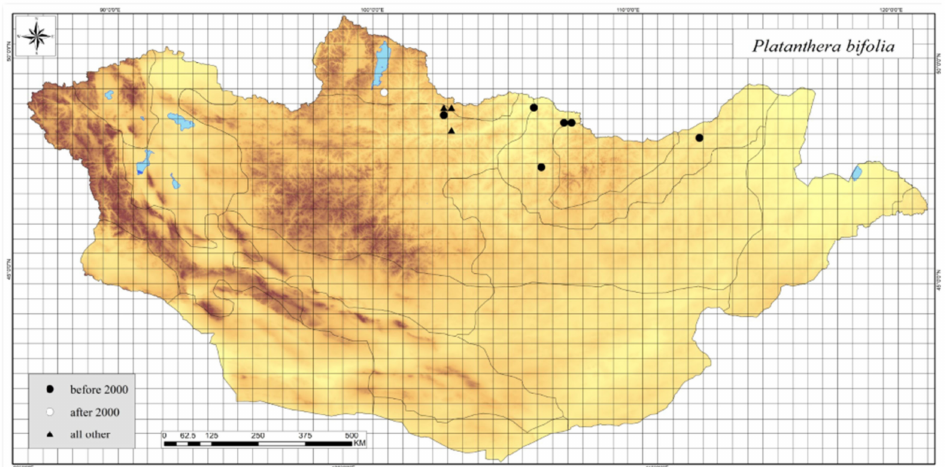
Figure A22. Distribution map of Platanthera bifolia in Mongolia.